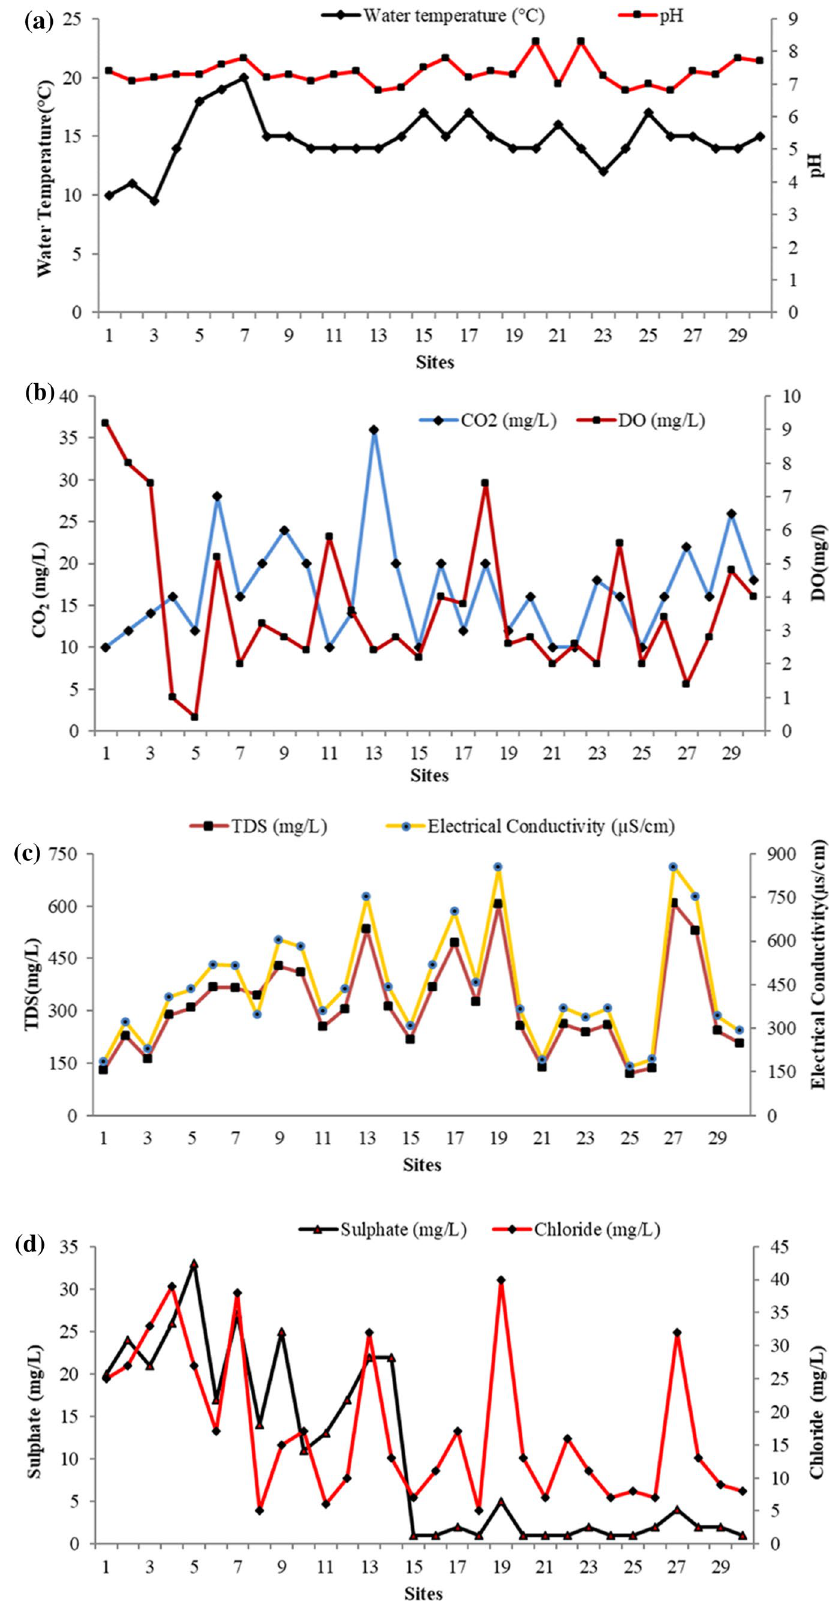
Fig. 3 Cross-plots between various water quality param- eters of the spring waters at different study sites a Water temperature (°C) and pH b CO 2 (mg L −1 ) and DO (mg L −1) c TDS (mg L −1 ) and Conductivity (µs cm −1 ) d Sulphate (mg L −1 ) and Chloride (mg L −1 ) e Total hardness (mg L −1 ) and Calcium content (mg L −1 ) f Total phos- phorus (µg L −1 ) and Orthophos- phorous (µg L −1 ) g Nitrate (µg L −1 ) and Ammonia(µg L −1